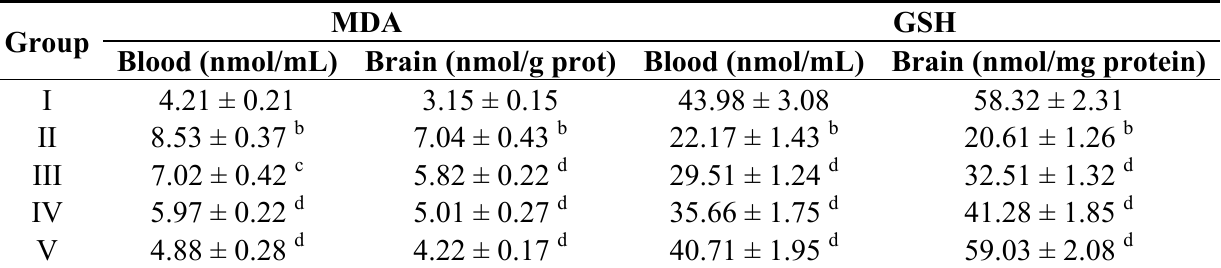
Table 4. Effects of sevoflurane postconditioning on serum and brain MDA, GSH